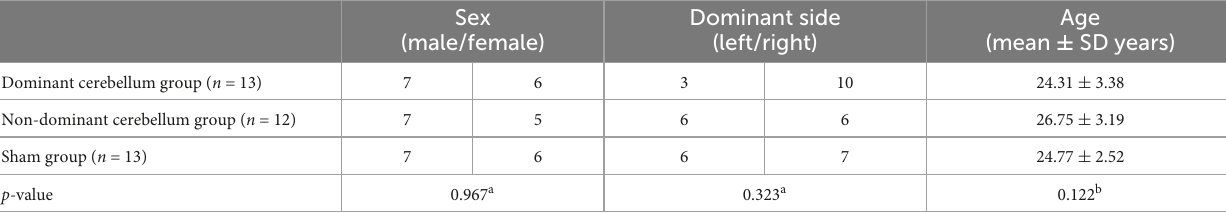
TABLE 1 Demographic information of subjects.